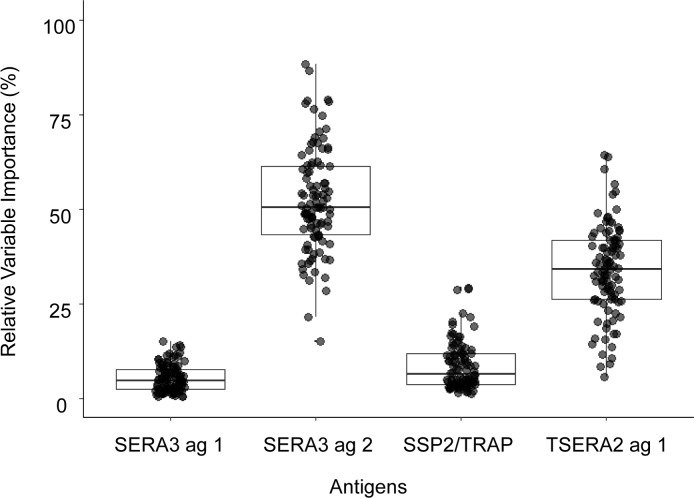
Relative variable importance of responses to each antigen from 100 boosted regression tree models predicting P. knowlesi seropositivity.Median values for the relative variable importance and interquartile ranges are shown for all antigens tested: SERA3 ag 1 (4.8%; IQR 2.5–7.8%); SERA3 ag 2 (50.4%; IQR 43.3–61.4%); PkSSP2/TRAP (6.5%; IQR 3.7–11.8%) and TSERA ag 1 (34.2%; IQR 26.2–41.8%).